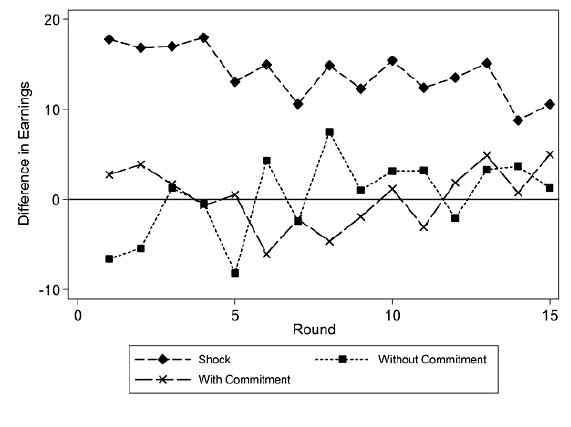
Fig. 4 . Consumption smoothing (average earnings: not Shocked minus